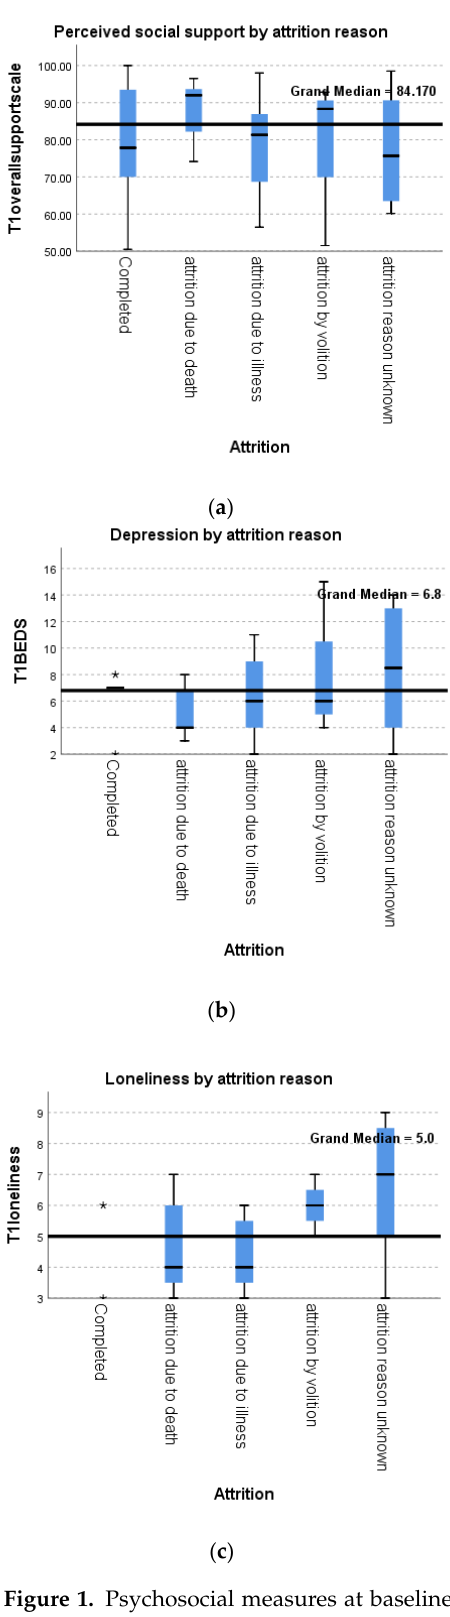
Figure 1. Psychosocial measures at baseline by reason for attrition: ( a ) Perceived social support; ( b ) Depression; ( c ) Loneliness. *: In a box plot, the interquartile range is shown as a box, and the median shown as a line. Asterisks are data points >1.5 times the median value.